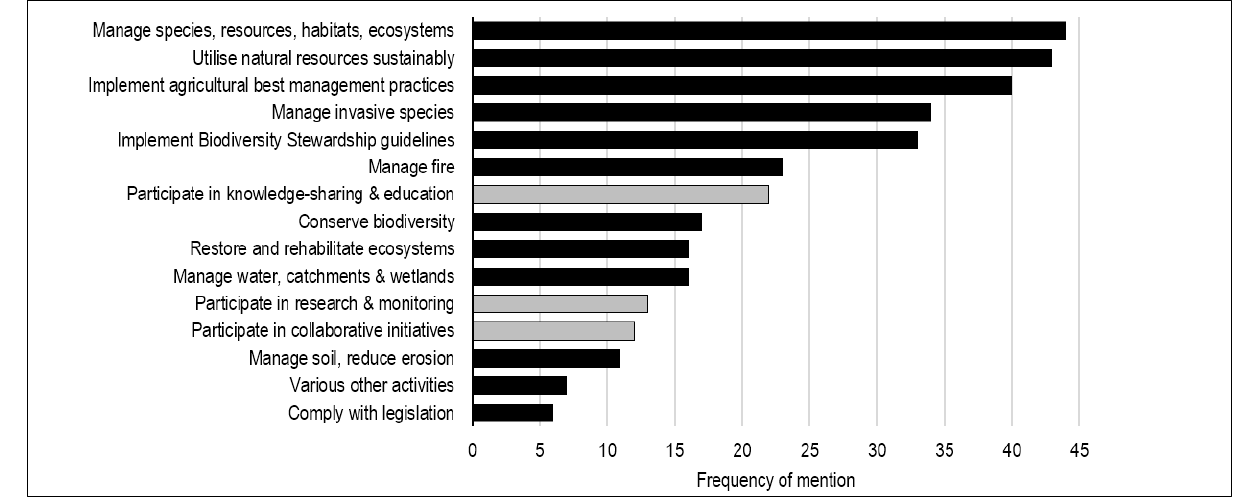
Figure 3: Stewardship actions which practitioners expect stewards to implement. Black bars indicate stewardship actions focused on ecological outcomes; grey bars indicate stewardship actions related to social outcomes ( n